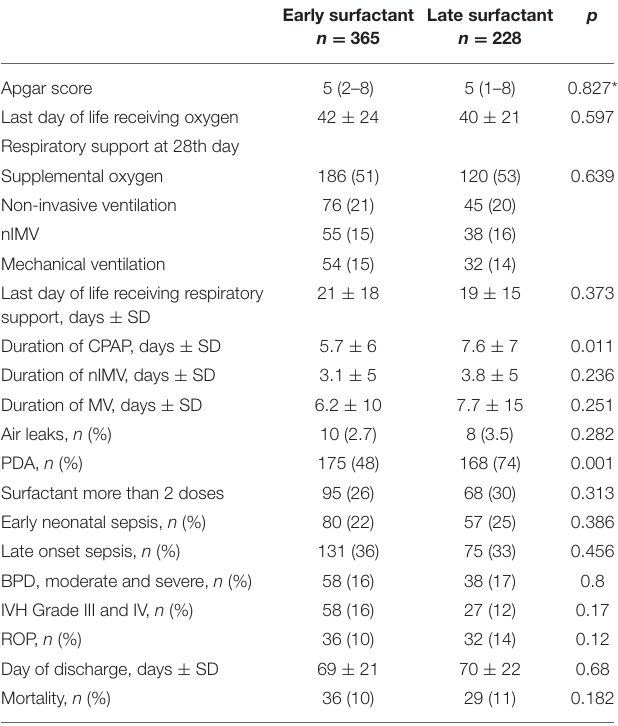
TABLE 2 | Comparison of clinical outcomes of study population.